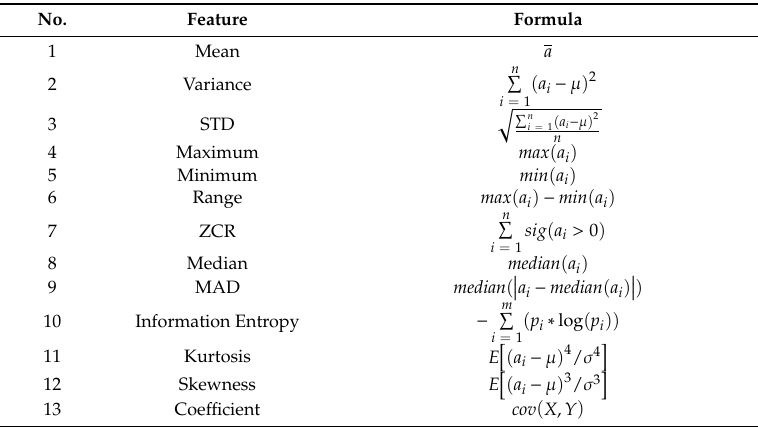
Table 3. Duration of each